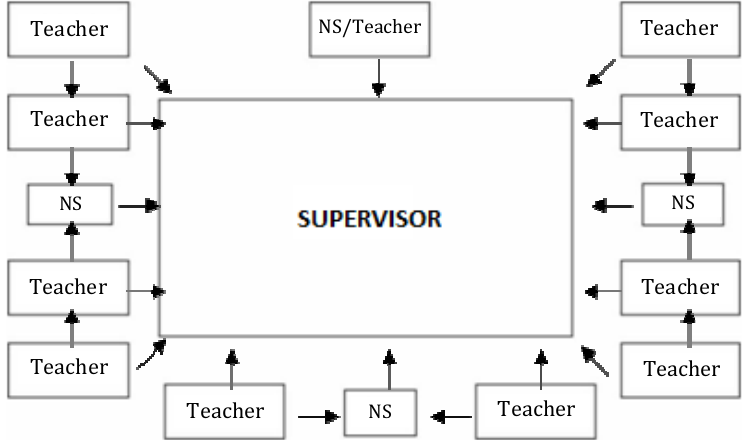
Fig. 3 Chart of Learning Supervision